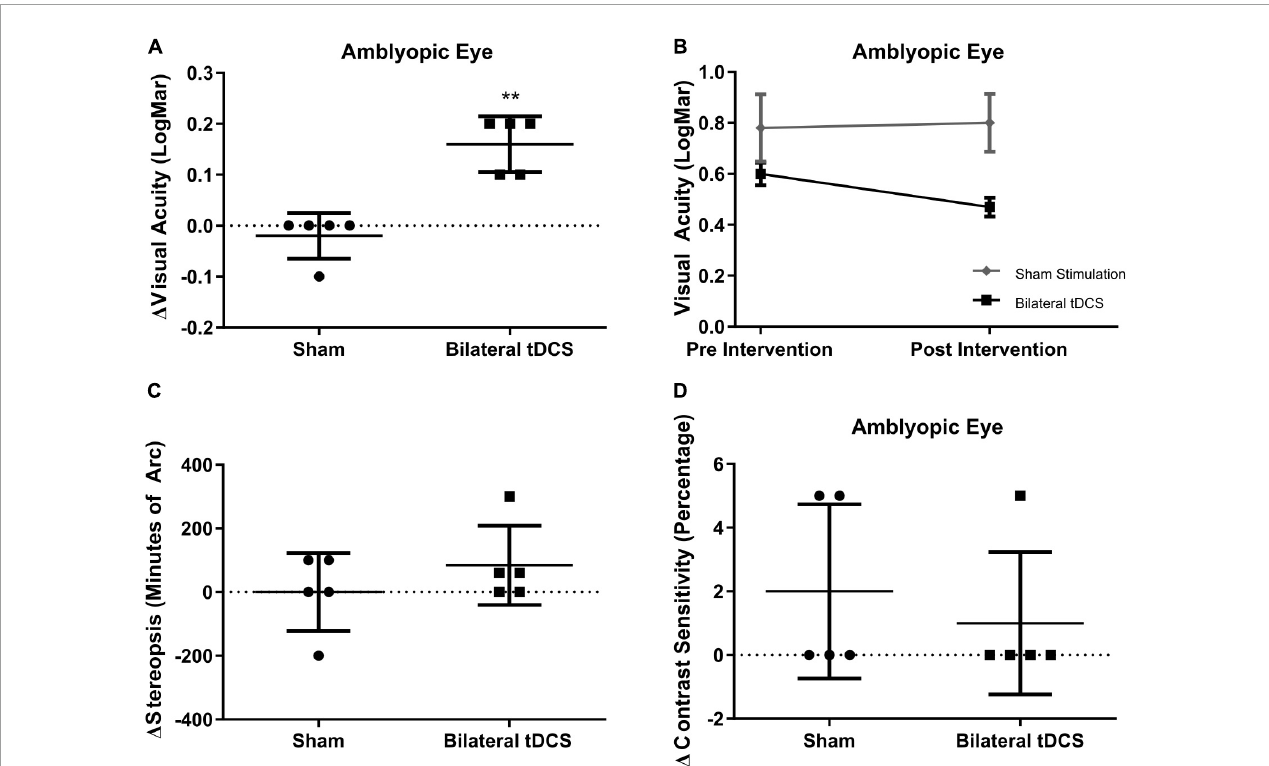
FIGURE2 Effects of bilateral-transcranial direct current stimulation (tDCS) on visual acuity, contrast sensitivity and stereopsis. (A) Changes in visual acuity of amblyopic eye between groups. (B) Pre-Post comparison of visual acuity of amblyopic eye between groups. (C) Changes in stereopsis between groups. (D) Changes in contrast sensitivity between groups. Mean and standard deviation are shown in (A,C,D) . Mean and standard error of mean are shown in (B) . For statistical significance analysis Mann-Whithney U-Test was used, ** p = 0.0079, Effect Size 2.928 (Cohen’s d). Sham stimulation n = 5; Bilateral tDCS n =